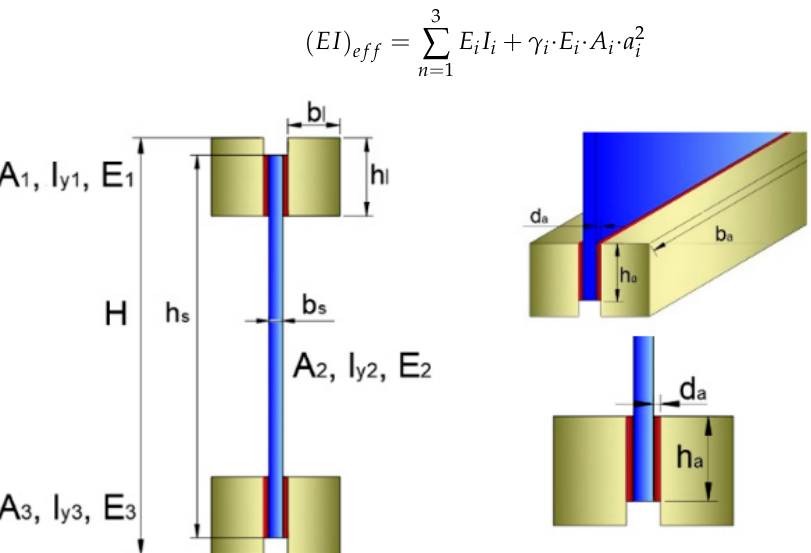
Figure 1. Schematic drawing of the symbols for the calculation of